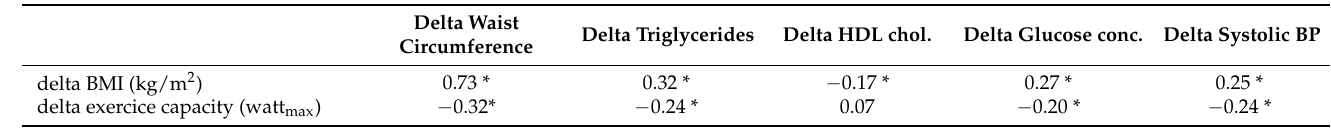
Table 2. Correlation of Intervention–induced Changes in BMI and Exercise Capacity with Changes in Features of MetS.